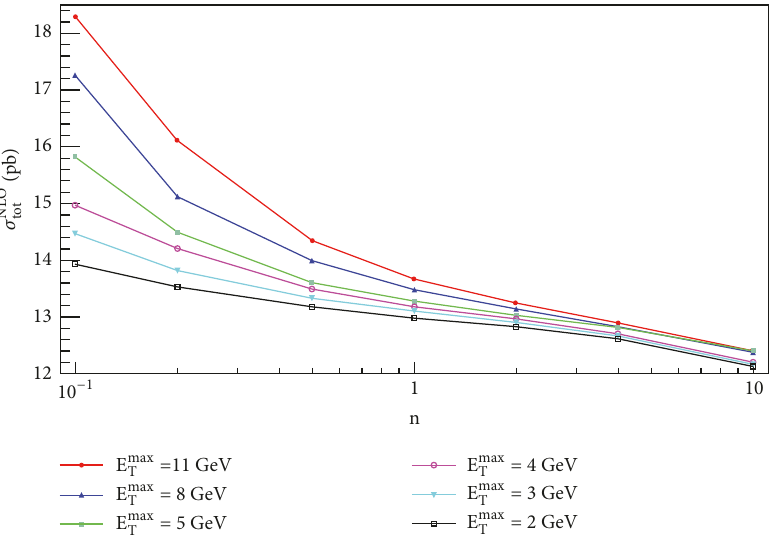
Figure 1: The MATRIX integrated fiducial cross-section 𝜎 𝑁𝐿𝑂 𝑡𝑜𝑡 as a function of the parameter 𝑛 related to Frixione isolation criterion (see (5)) for different values of 𝐸 max 𝑇 .